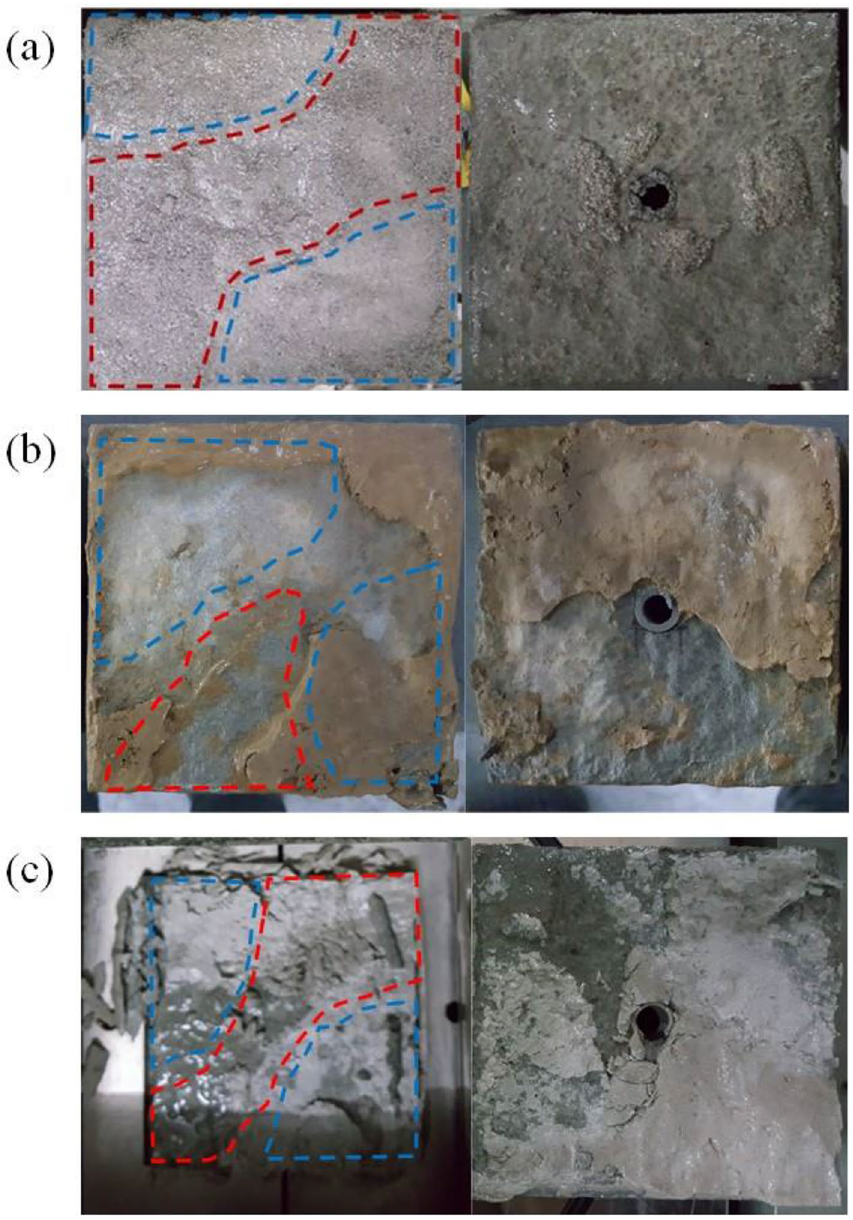
Figure 10. Damage to the fill layer after shear deformation for different materials: ( a ) sand, ( b ) clay, ( c ) gypsum. The images which feature a hole are the upper halves of the samples. (“dashed red” are main water flow regions, “dashed blue” are main stress concentration